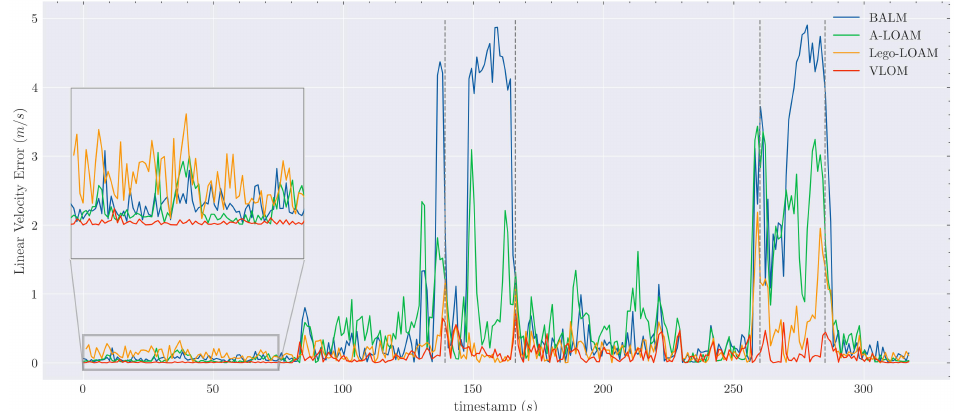
Figure 10. Comparison of the linear velocity errors on HK-Data20190117 . VLOM has a very low error throughout the sequence, especially during the initial phase shown in the magnified area.